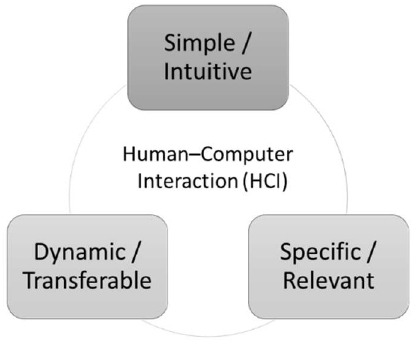
Figure 1. Standard HCI requirements.